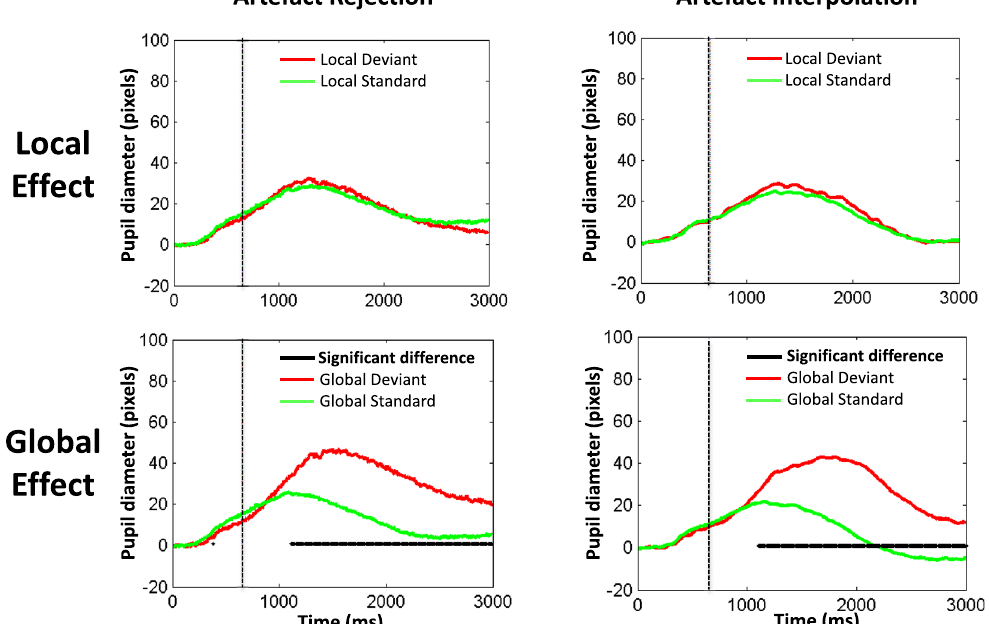
Figure 3. A pupil dilation occurred during violations of global regularity. Grand-averages of right eye pupil horizontal diameter (in pixels) are plotted over time (in milliseconds) in the active counting version of the ‘local global’ task both for the local (upper panels) and global (lower panels) effects. The artefact rejection (N = 56 participants; left panels) and artefact interpolation (N = 60 participants; right panels) methods led to the same results. While the event-related pupil response was undistinguishable between local standard (green curves) and local deviant (red curves) trials, a strong global effect was observed: a significant (black horizontal segments) pupil dilation was observed in response to global deviant trials. This effect began around 1 second after trial onset, peaked around 1.5 second and was sustained during more than 3 seconds. This effect was observed on horizontal and vertical diameters of both eyes. The vertical dotted line indicates the temporal offset of the five sounds defining a